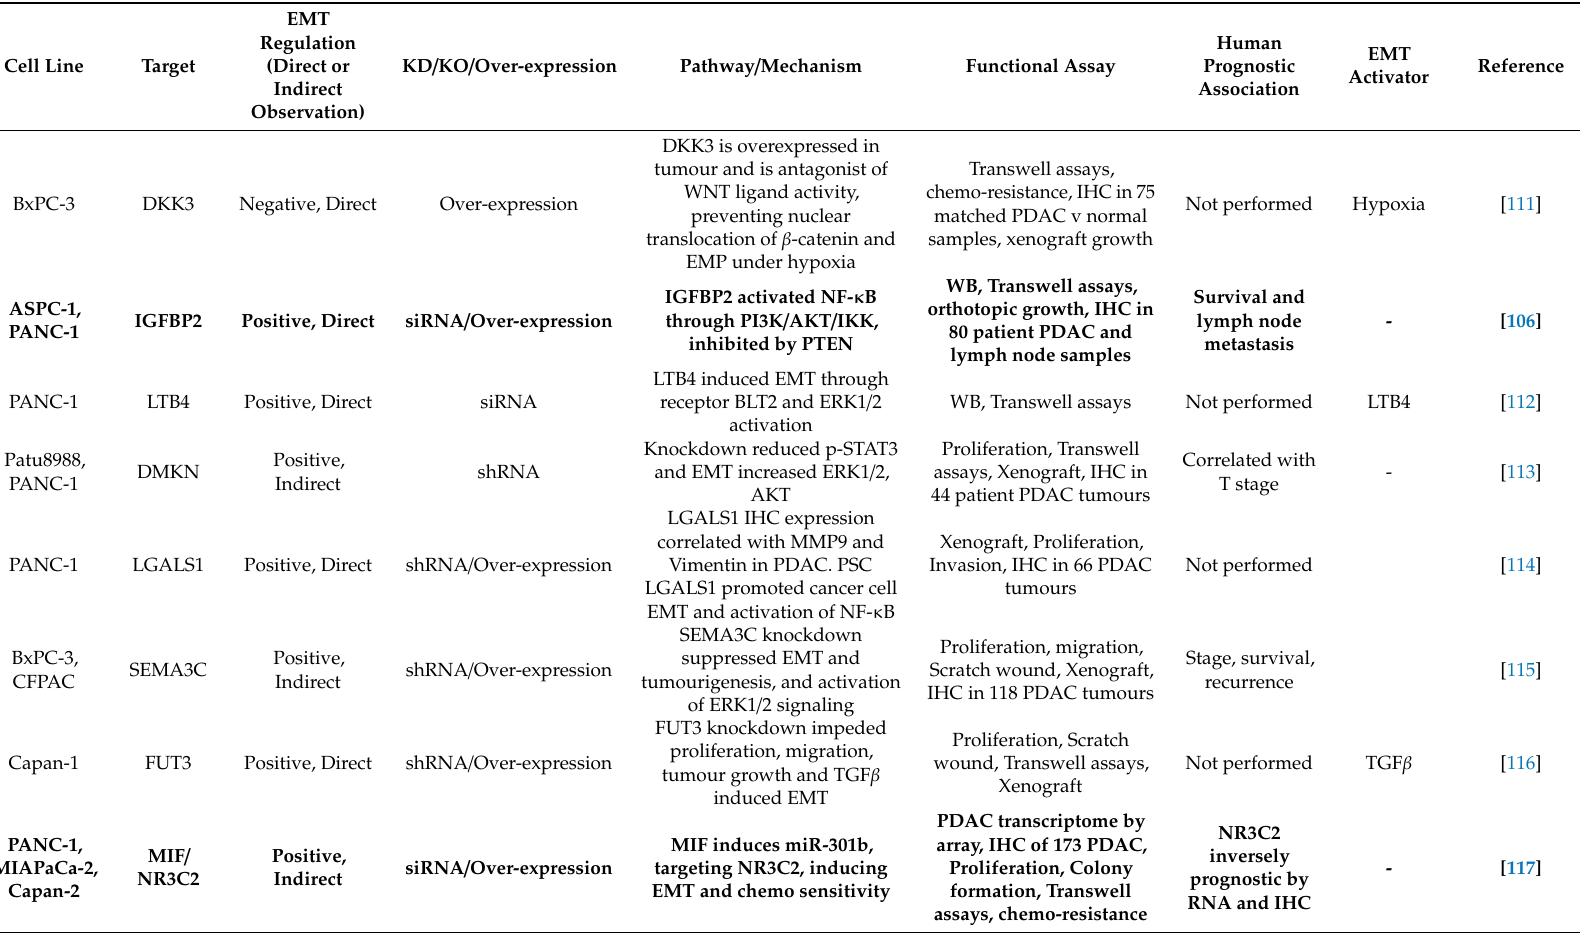
Table 1. Soluble and secreted factors that influence EMP. This table describes novel candidates that may be secreted within the ECM and act either directly through ligand-receptor interactions, or through mechanisms that remain to be demonstrated. Candidates that exhibit clinical correlation with lymph node metastasis are shown in